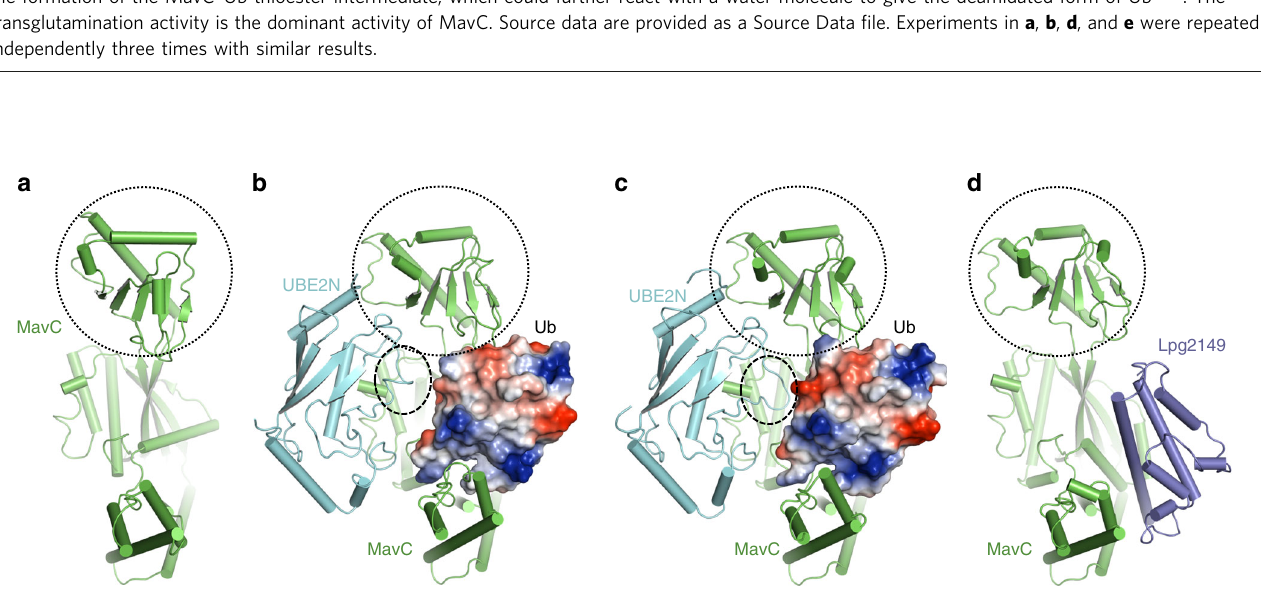
Fig. 6 Overview of the structures in this study. a – d Overall structures of apo MavC ( a , PDB: 5TSC), MavC/UBE2N/Ub complex b , MavC/UBE2N-Ub complex c , and MavC/Lpg2149 complex d . Ub is shown in electrostatic surface model. The insertion domain of MavC and the K92 loop region of UBE2N are marked with